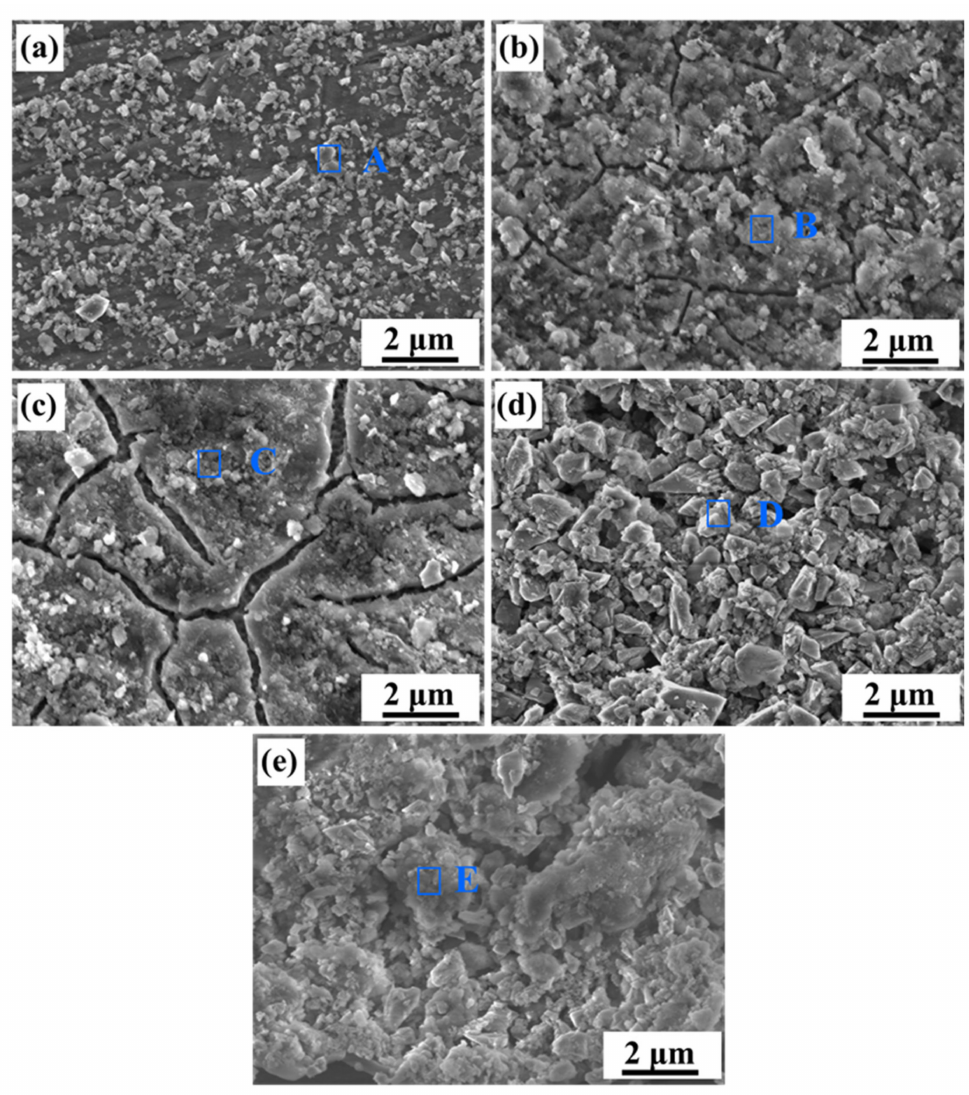
Figure 9. Corrosion morphologies of the alloys A–E after immersion in the aerate 3.5 wt.%NaCl